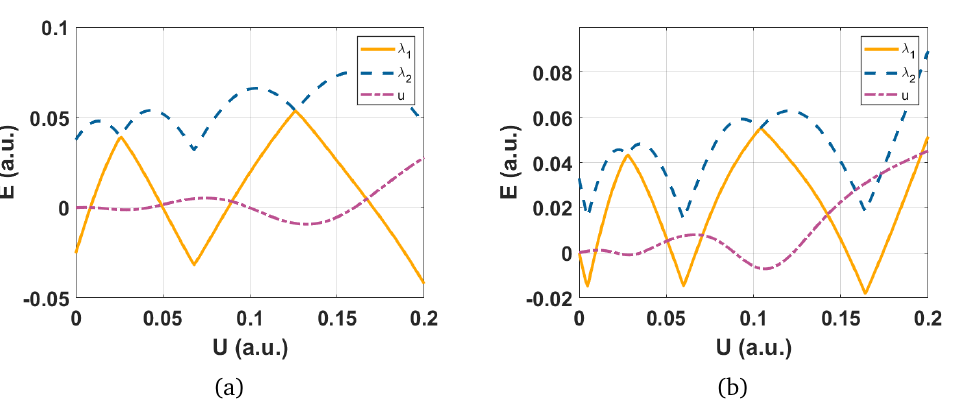
Figure 14: Other interaction terms we checked are - (a) = U (cid:80) = U (cid:80) H c † c c † c , (b) H i i + 1 int int i i i + 1 = U (cid:80) c † c c † c (d) H . All other parameters are tuned to the optimal i i + 4 int i < j i i + 4 (cid:12) (cid:12) point at which (cid:12) E | 11 〉 − E | 00 〉 (cid:12) (cid:39) 0: t = 0.4025, ∆ = 0.2167, µ t1 = 0.4832, µ = 0.4832, µ = 8.5364 for N = 10 site Kitaev chain with non-topological t2 nt = 4, n = 7. segment: n nt 1 nt 2